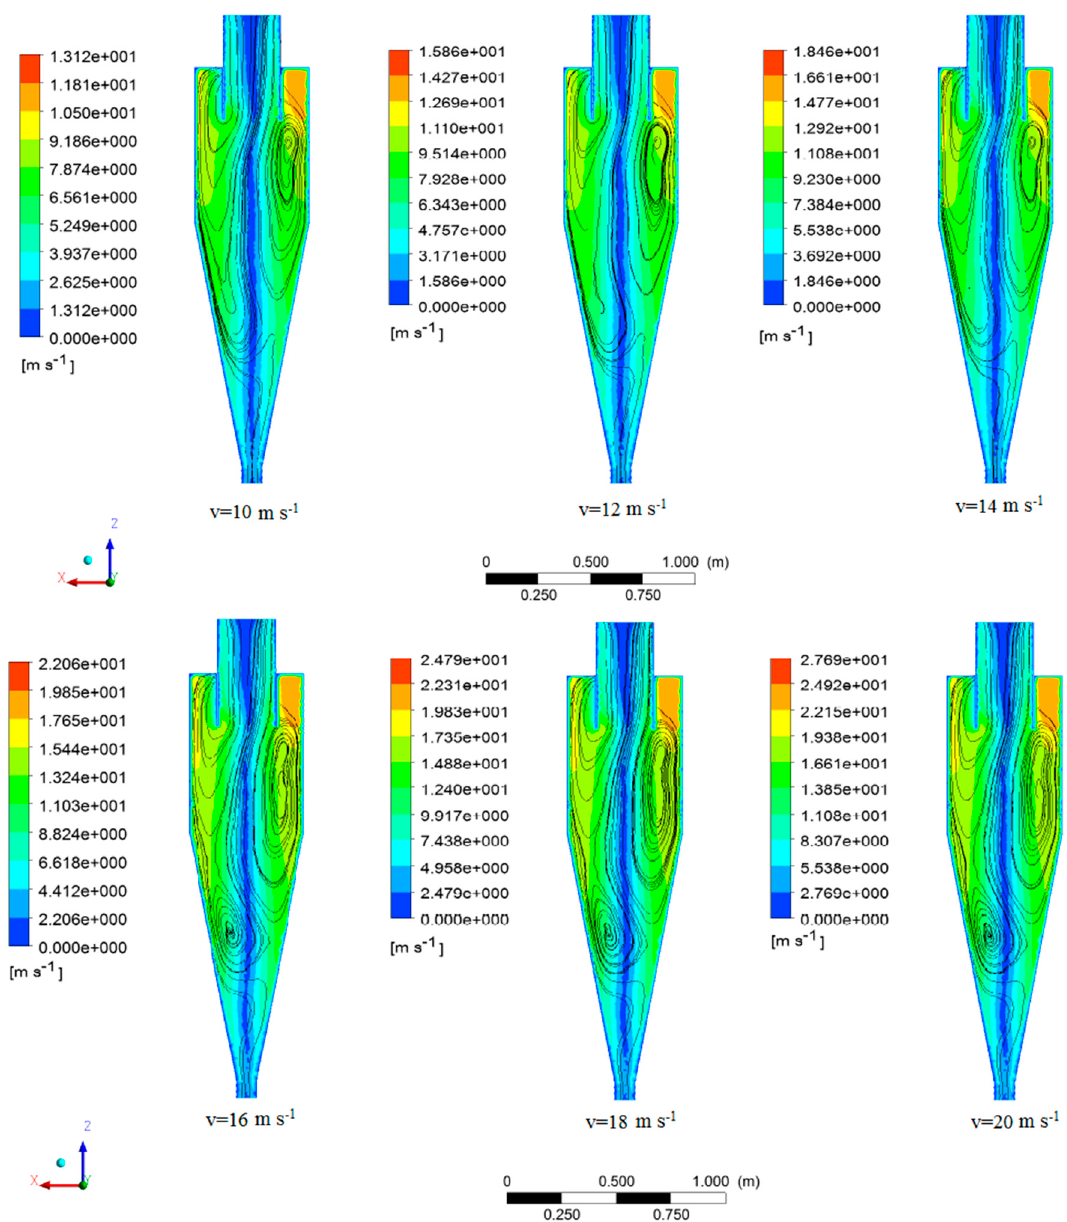
Figure 11. Streamline contours in various inlet velocities.